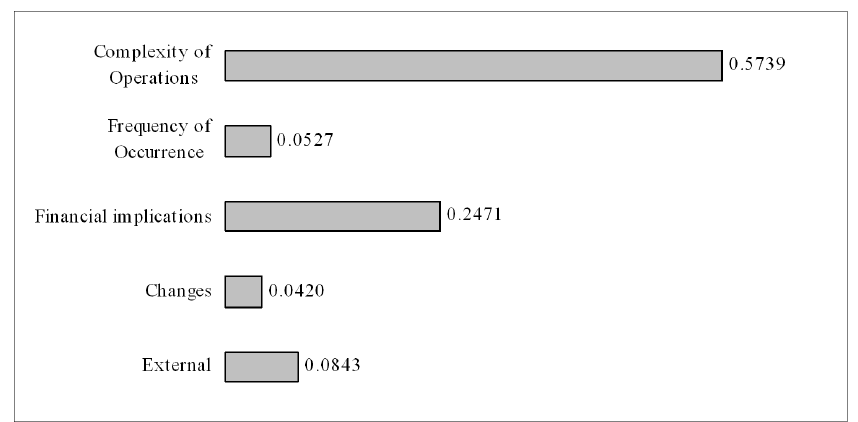
Figure 4: Importance scale for risk factors.